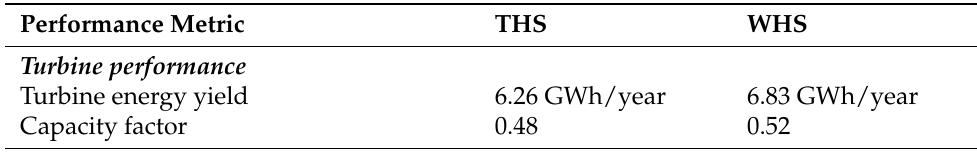
Table 1. Annual performance of the tidal and wind hybrid